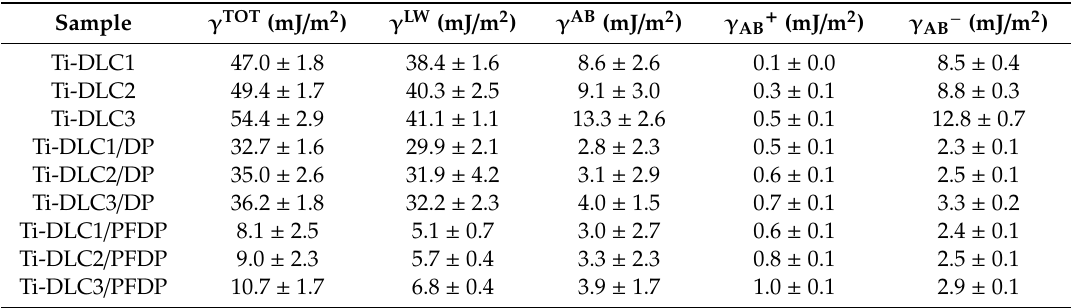
Table 2. Surface free energy and their components estimated for di ff erent Ti-DLC coatings with and without perfluoro and alkylphosphonic self-assembled